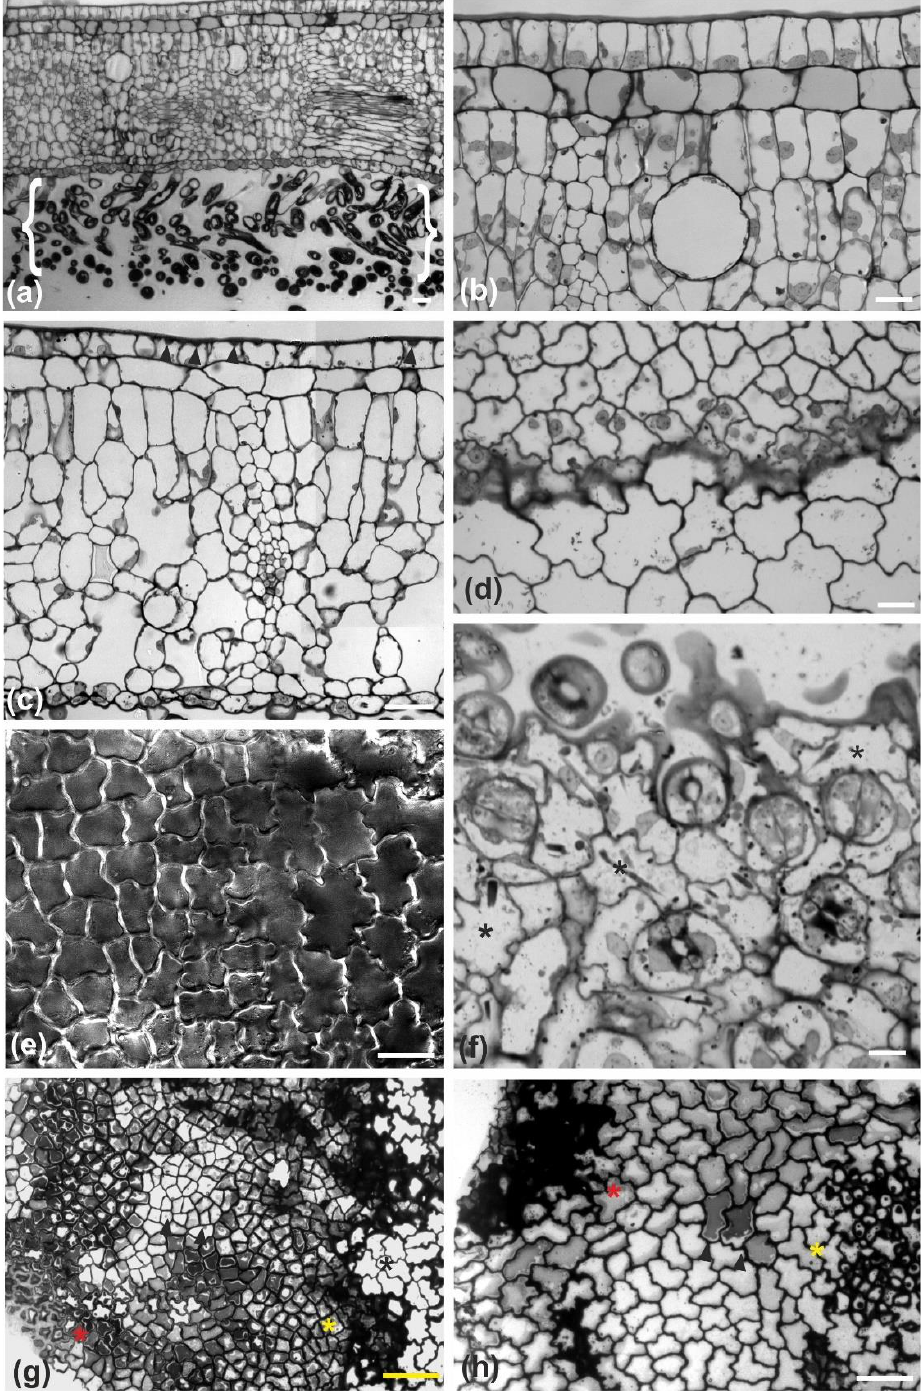
Figure 1. Light micrographs of developing ( a – f ) and fully mature ( g , h ) adaxial ( a – e , g , h ) and abaxial ( f ) leaf epidermis of Magnolia grandiflora , after toluidine blue staining of transverse ( a – c ) and paradermal ( d , f – h ) sections, or hand-cut section viewed with DIC optics ( e ). ( a ) Bi-layered adaxial and single-layered abaxial epidermis can be observed in this young leaf, the latter covered by a thick layer of trichomes (brackets). At higher magnification, it is observed that cell profiles of the two adaxial epidermal cell layers are totally unrelated ( b ). At a later developmental stage ( c , see local wall thickenings pointed by arrowheads in the external epidermal cells), both adaxial epi- dermal layers appear continuous and integral. The cells of the external layer are smaller than those of the hypodermis, as observed at transverse ( c ) and paradermal ( d ) view. This was also confirmed by DIC observations of fresh unfixed epidermis ( e ); the external epidermis is on the left side of the image and the hypodermis on the right. Additionally, note that the waviness pattern among the